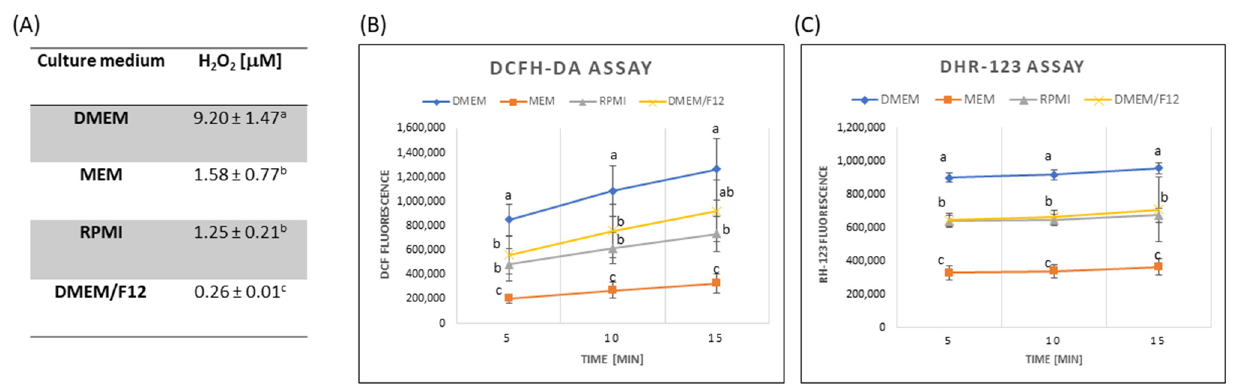
Figure 1. Reactive oxygen species (ROS) generation in mammalian cell culture media. ( A ) Production of H 2 O 2 assessed by oxidation of acetyl dihydroxy phenoxazine (ADHP), ( B ) ROS production measured by oxidation of 2 ′ ,7 ′ -dichlorodihydrofluorescein diacetate (DCFH 2 -DA), and ( C ) dihydrorhodamine (DHR-123). Cell culture media were incubated for 5 min (panel ( A )) or 5–15 min (panels ( B , C ) at 37 °C, 5% CO 2 atmosphere. The data represent the mean ± SD derived from 2 independent experiments each performed at least in four replicates. Means at the same time point followed by a common letter are not significantly different. The data were analysed by one-way ANOVA followed by Dunnett’s T3 post hoc test.